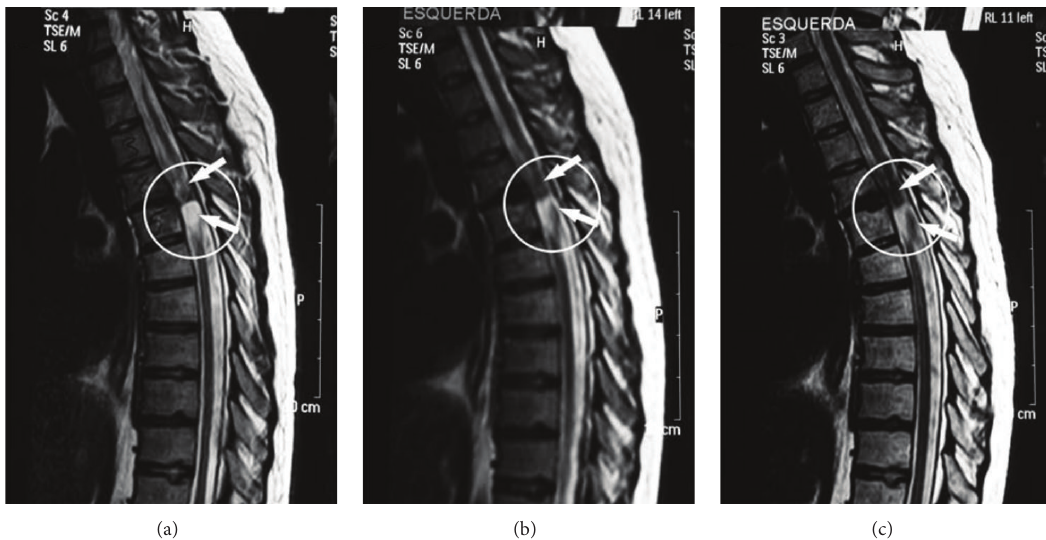
Figure 7: Examples of sagittal resonance images of the spinal cord at the site of the injury, T4-T5 level (white circle) obtained from patient 5 before (a) and 20 and 35 days after labeled-CD34 + cells transplantation ((b) and (c), resp.). The suggested CD34 cell migration into the injured site is demonstrated as hypointense areas (black areas) in (b) and (c) (arrows). These hypointense areas are not seen in (a) (arrows)